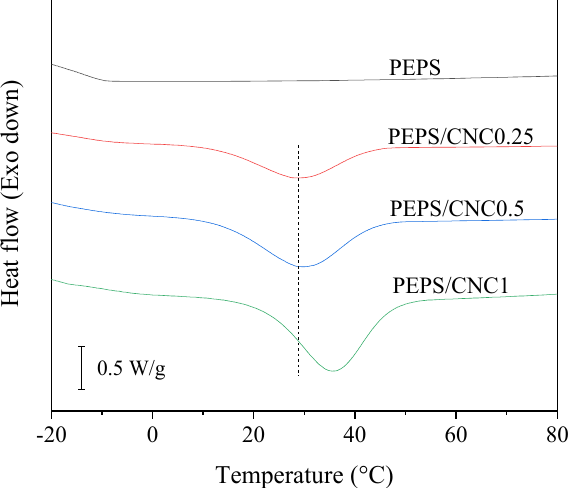
Figure 3. Melt crystallization behavior of PEPS and PEPS/CNC composites at 20 ° C/min. The well-known Avrami equation was utilized to analyze the isothermal crystalliza- tion kinetics of PEPS and PEPS/CNC composites. Relative crystallinity shows a relation- ship with crystallization time as follows: